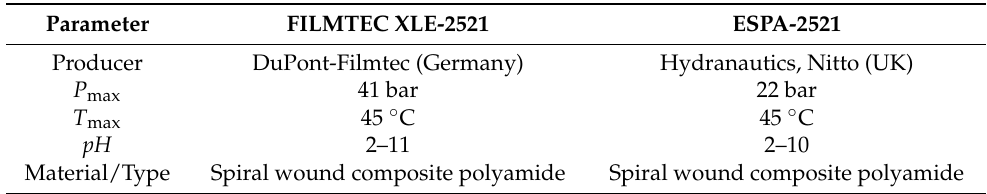
Table 1. The RO membranes’ characteristics.